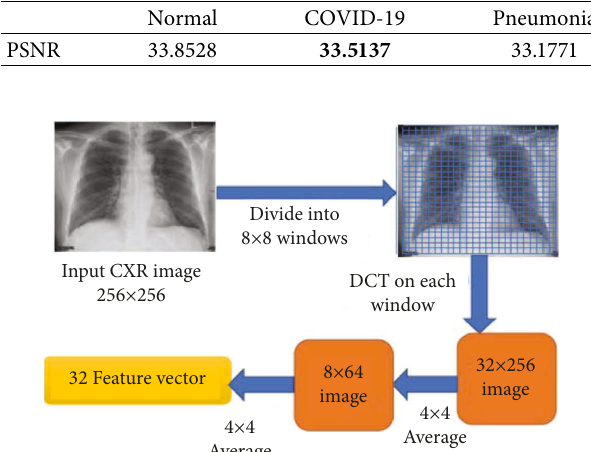
Table 2: PSNR for compressed CXR images.